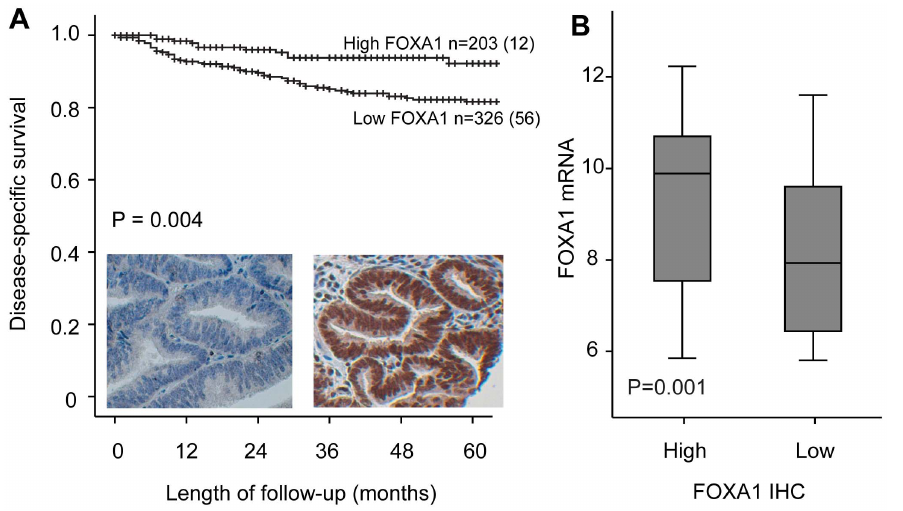
Figure 1. FOXA1 and survival. (A) Kaplan-Meier curve showing disease specific survival according to FOXA1 protein level. Low FOXA1 expression is significantly correlated with reduced survival for patients with endometrial carcinoma. Left and right insert shows low and high nuclear expression of FOXA1 respectively. (B) Low protein expression of FOXA1 is significantly correlated with low FOXA1 mRNA expression.